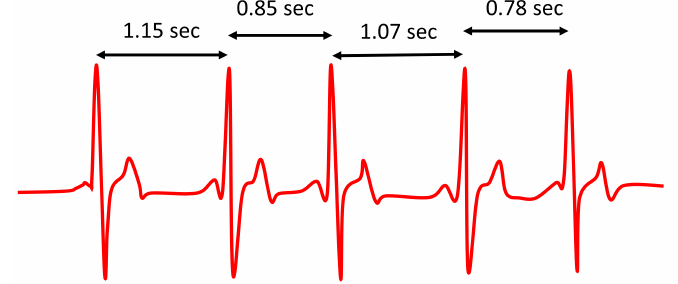
Figure 2. Variations of R–R intervals in an electrocardiogram (ECG)